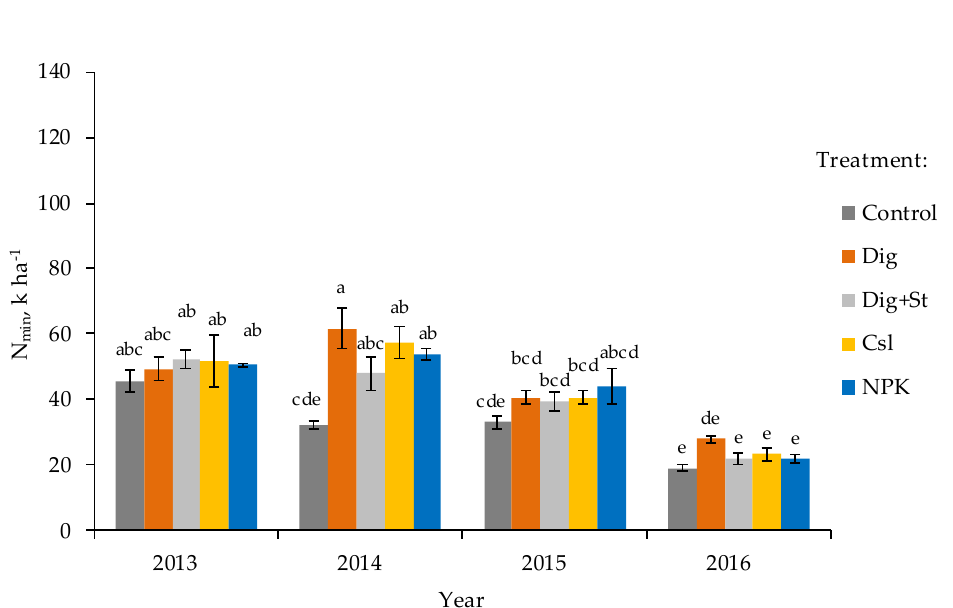
Figure 2. Mineral nitrogen content in 0.0–0.60 m soil depth (total N min ) in autumn (after harvest) depending on the interaction between year and fertilizer treatment. Different letters indicate statistically significant differences between treatments (HSD test). Hatched bars represent 2 × SEM ranges.